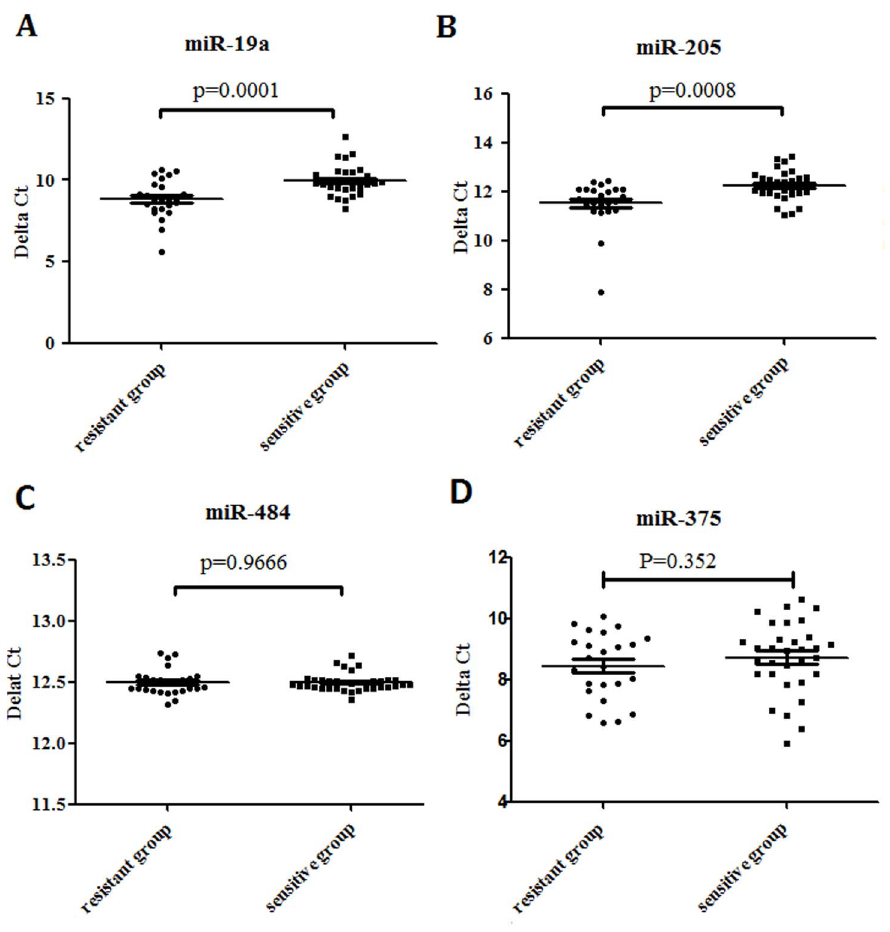
Figure 2. The scatter diagram of circulating miR-19a, miR-205, miR-484 and miR-375 in 56 luminal A breast cancer patients. Quantitative real-time PCR analysis of miR-19a, miR-205, miR-484 and miR-375 in resistant group (n=24) and sensitive group (n=32). Mean 6